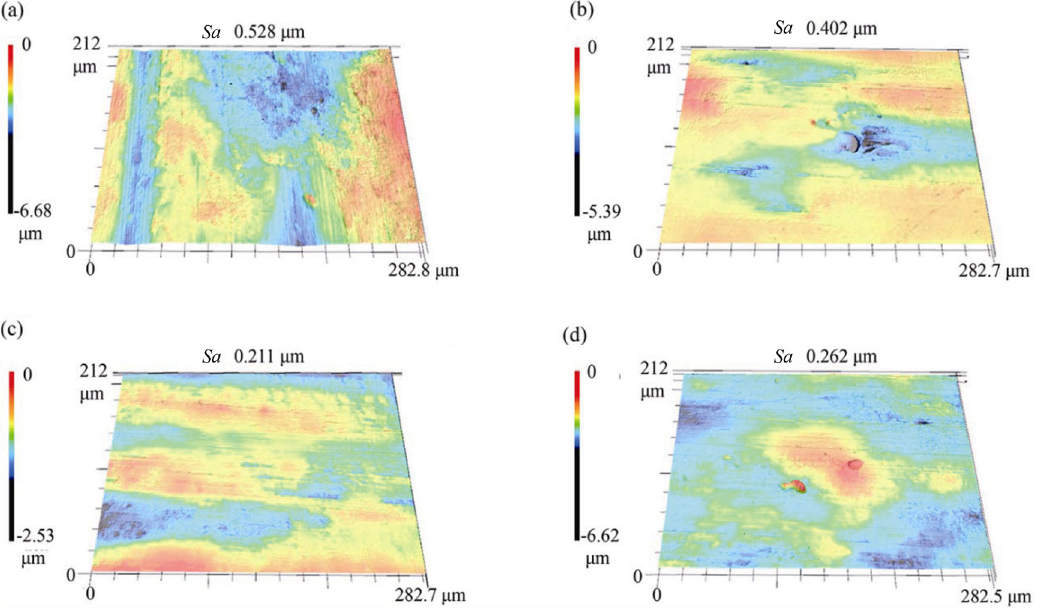
Fig. 9 3D wear surface topographies of polymer discs after the variable velocity tests under 5 N: (a) UHMWPE, (b) 50 DN, (c) 75 DN, and (d)